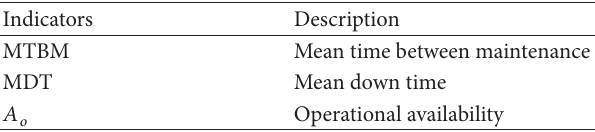
Table 3: ILS performance indicators.